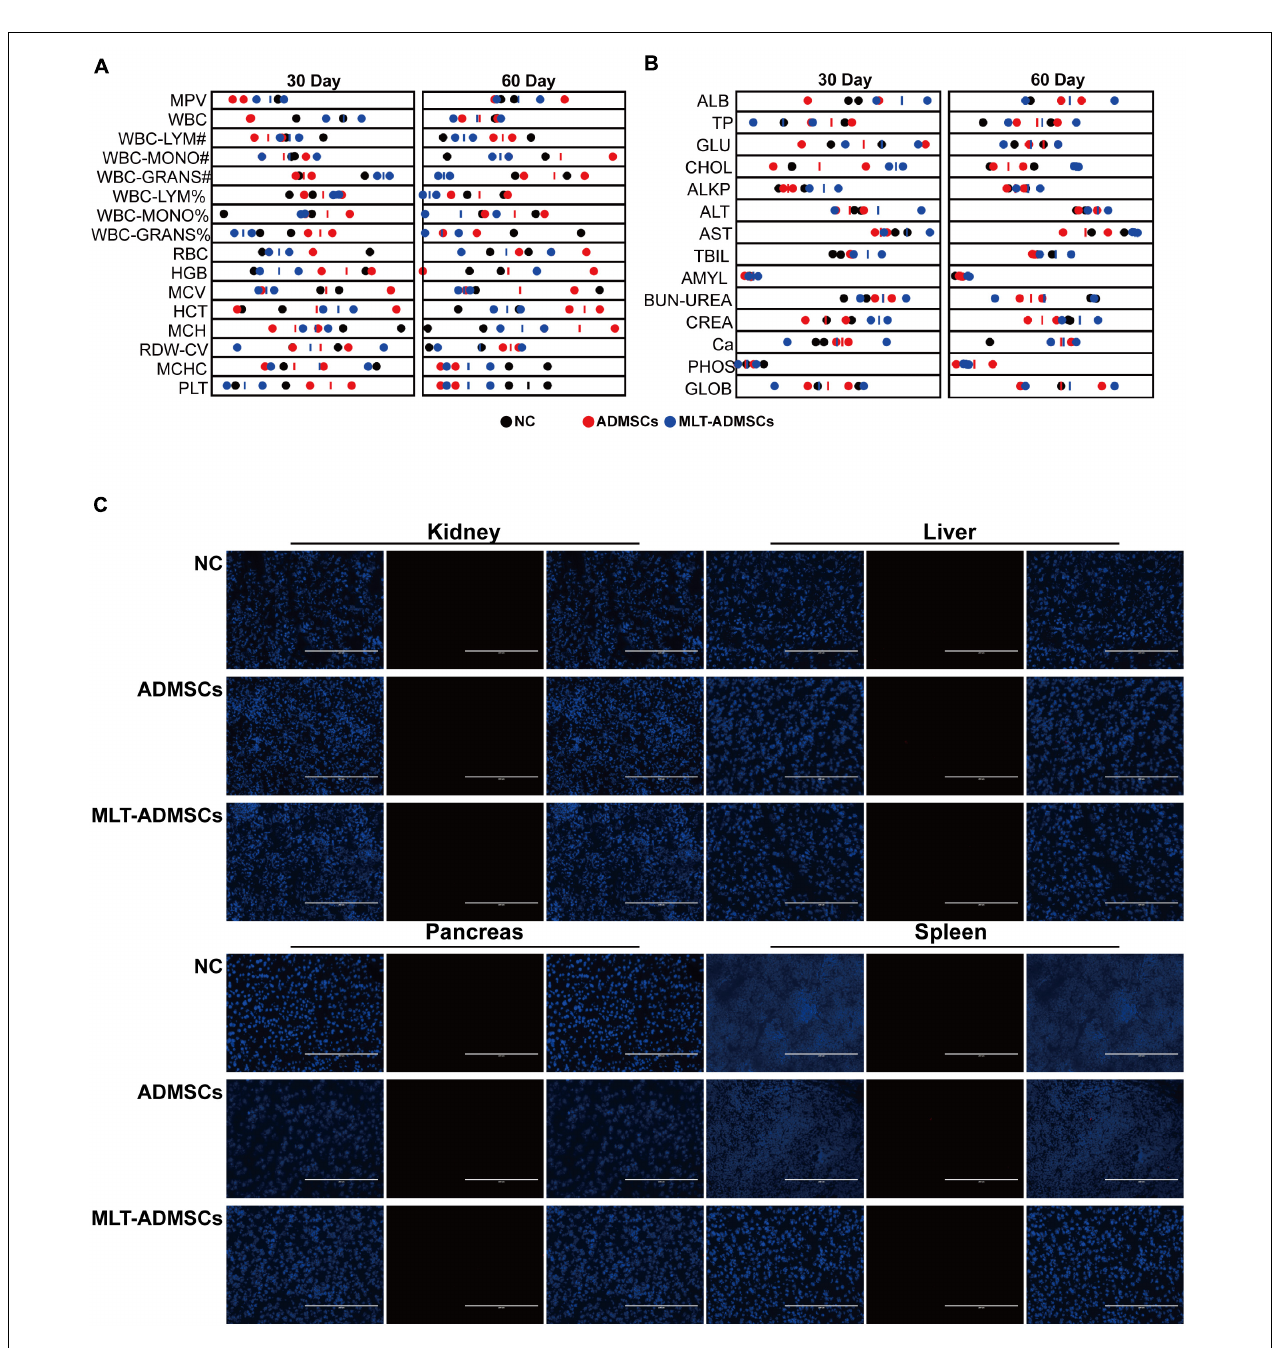
FIGURE 11 | Transplantation of ADMSCs and MLT-ADMSCs is safe for animals. (A) Routine blood examination. (B) Biochemical analysis. (C) PKH26